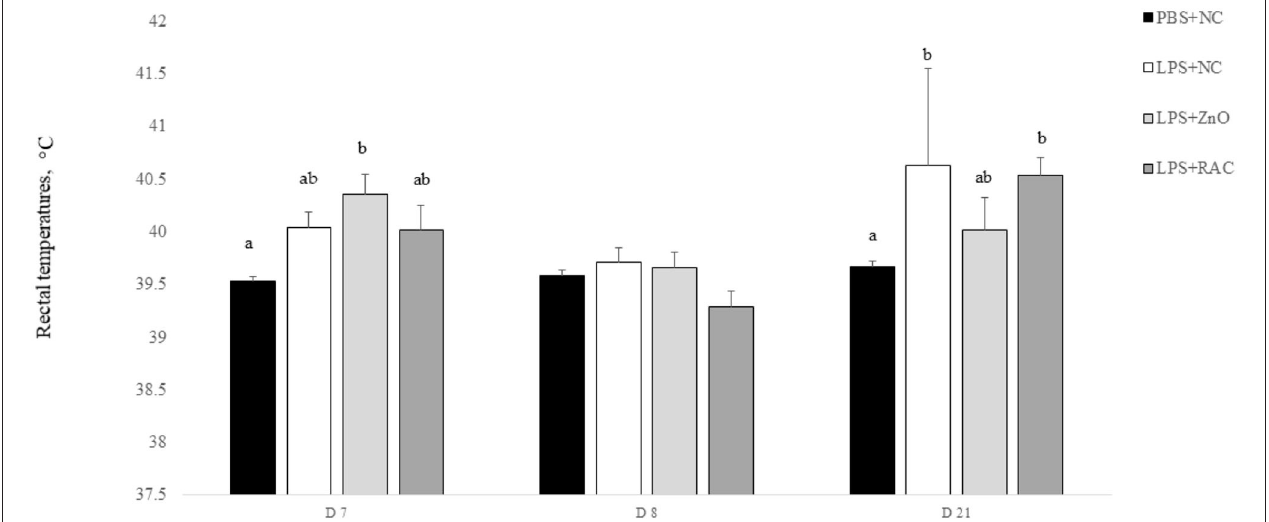
FIGURE 1 | Mean ( ± SEM) rectal temperature of piglets from the PBS + NC, LPS + NC, LPS + ZnO, and LPS + RAC groups. a,b Different superscripts indicate significant differences among treatments per sampling day ( P ≤ 0.05) 1 . 1 Rectal temperature was measured in all piglets at 6h after the LPS injection on days 7 and 21, and on day